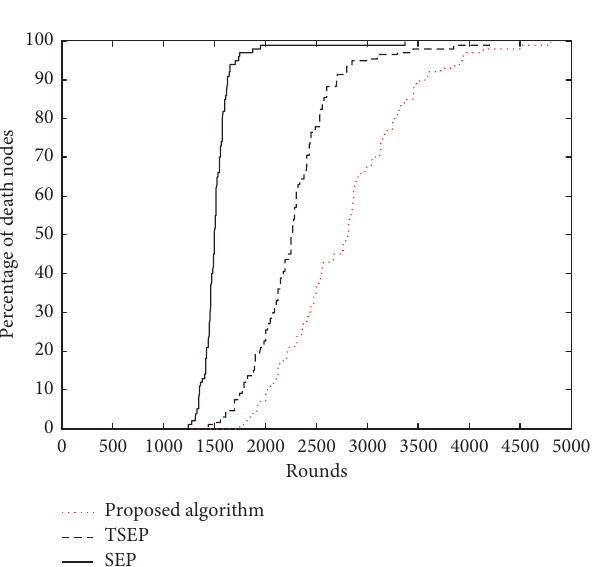
Figure 5: Throughput with tree zones.